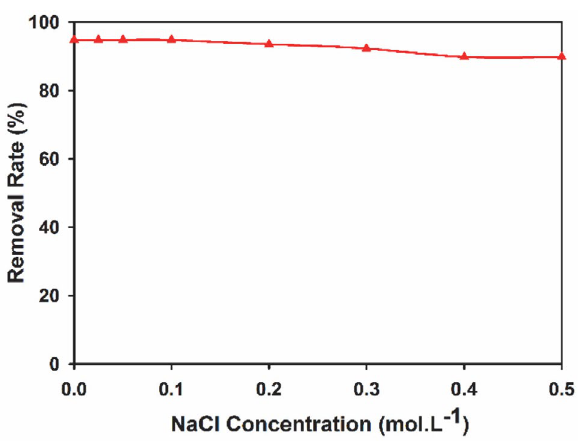
Figure 9. The effect of electrolyte on the bioreactor performance.